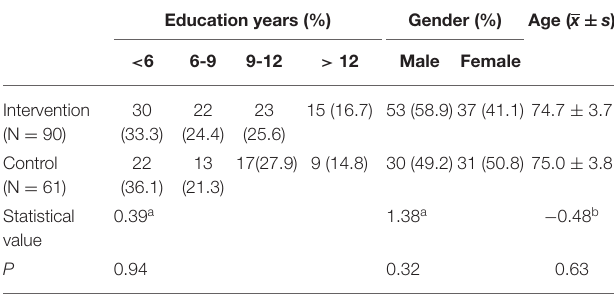
TABLE 1 | Baseline demographic